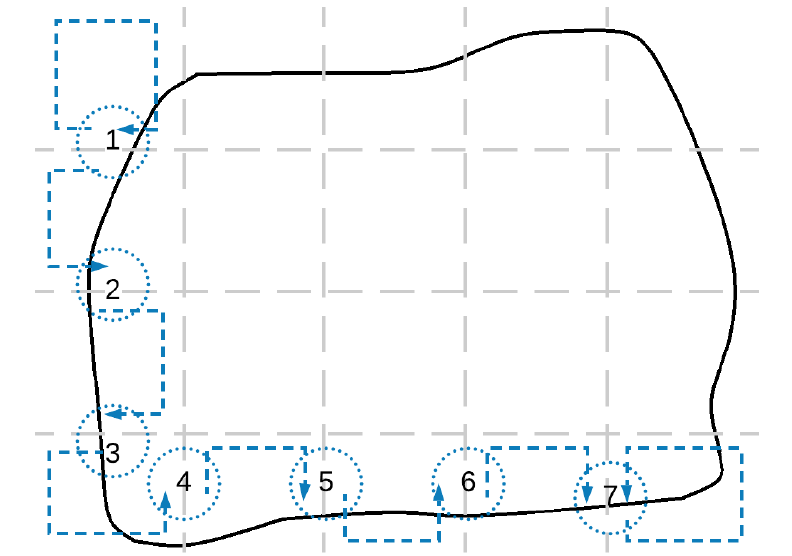
Figure 7. Required peer-to-peer communications to share an information between the two farthest UAVs, considering a 4 × 5 grid